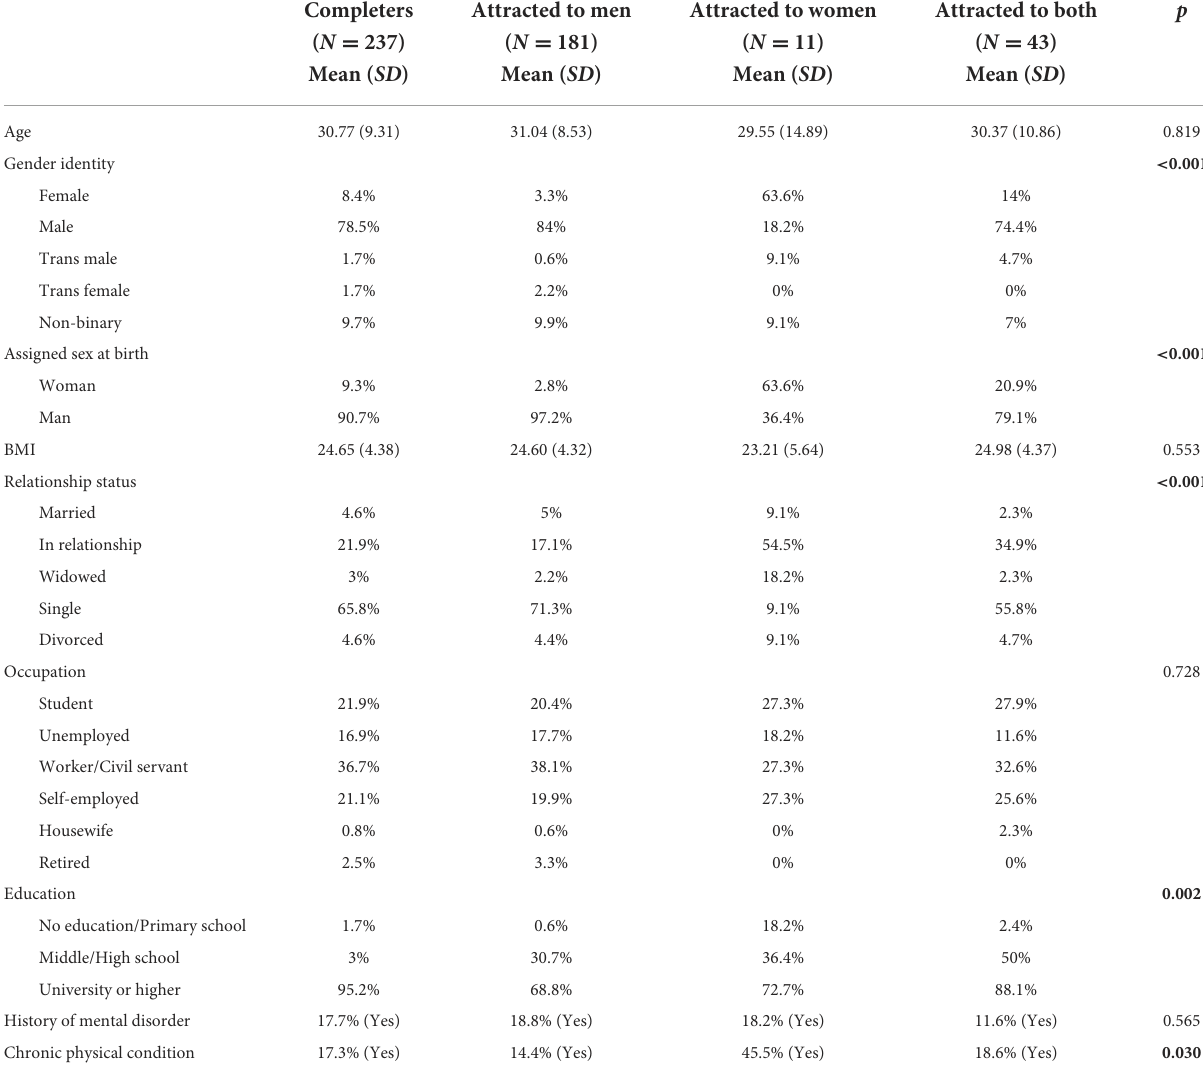
TABLE 1 Sociodemographic characteristics of the whole sample and differences by sexual orientation ( N = 237).